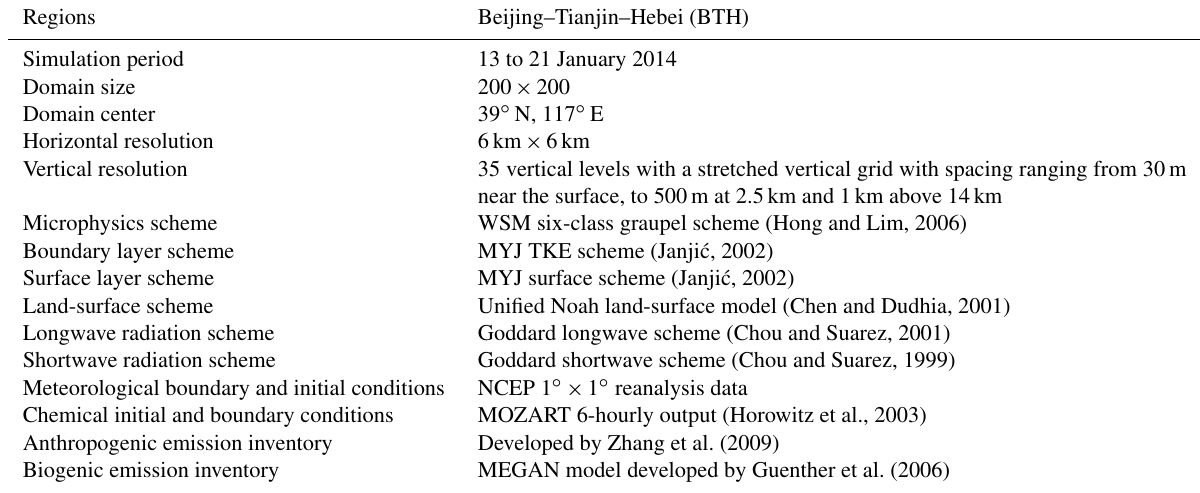
Table 1. WRF-CHEM model configurations.